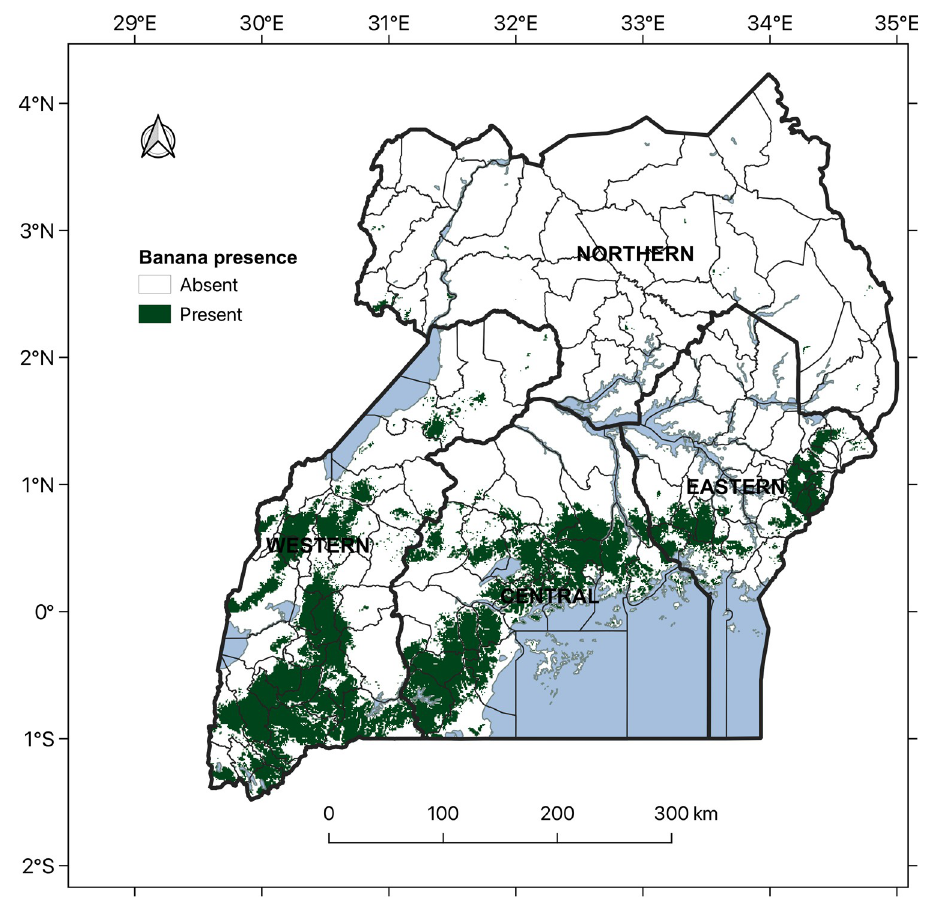
Fig 8. Predicted banana distribution map (2016) using logistic regression model M2-12 fitted using 12 covariates and significant two-way combinations.